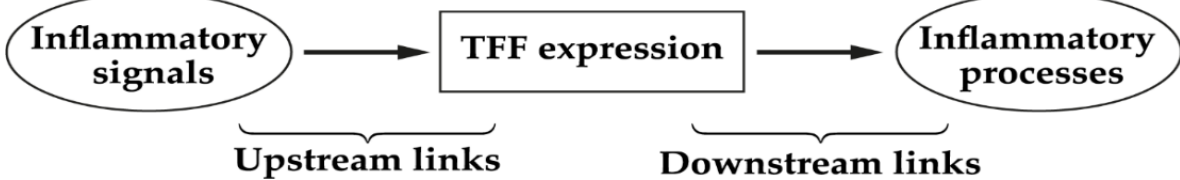
Figure 2. Schematic representation of the multiple links between TFF peptides and inflammation. TFF expression is regulated by inflammatory mediators (upstream); TFF peptides (or their loss) also influence inflammatory processes (downstream).